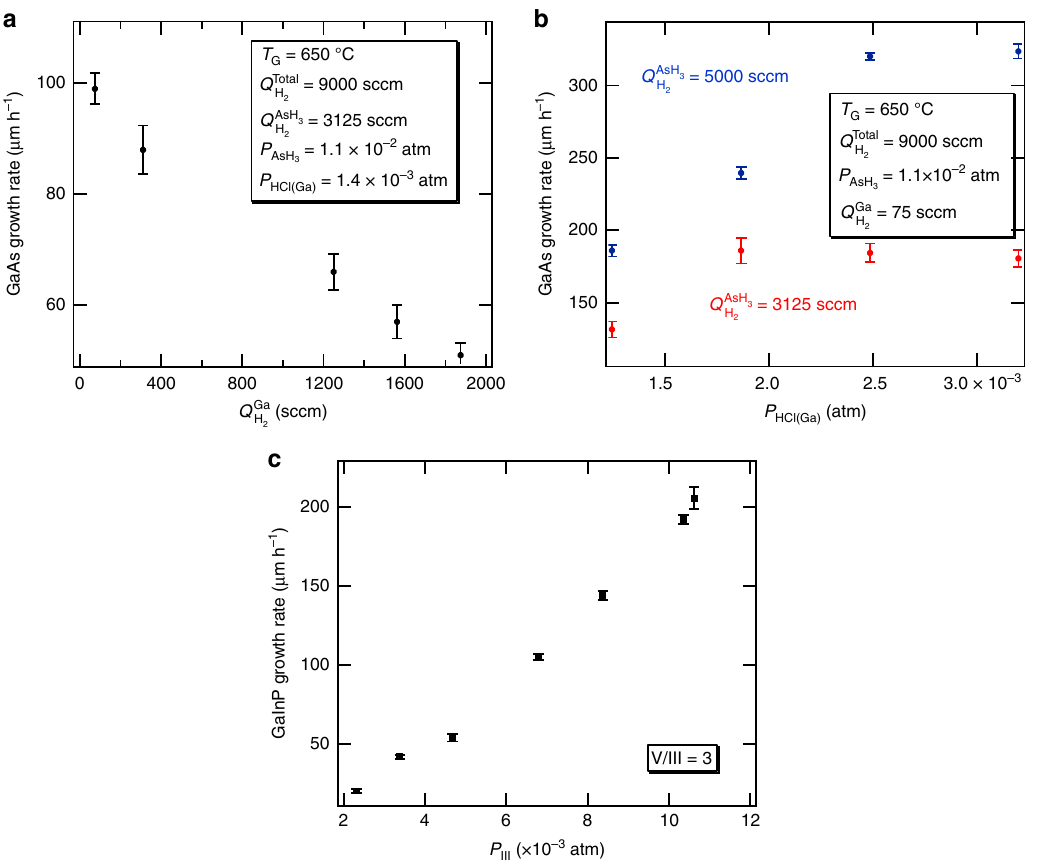
Fig. 2 Effect of growth parameters on growth rate. GaAs growth rate as a function of H 2 carrier fl ow rate through the Ga boat ( a ) and partial pressure of HCl(Ga) sent to the boat ( b ). Other growth parameters indicated in each fi gure and the total reactor fl ows were held constant and ( c ) growth rate of GaInP as a function of group III partial pressure by D-HVPE. Error bars are standard deviations of growth rate measured from multiple positions on the